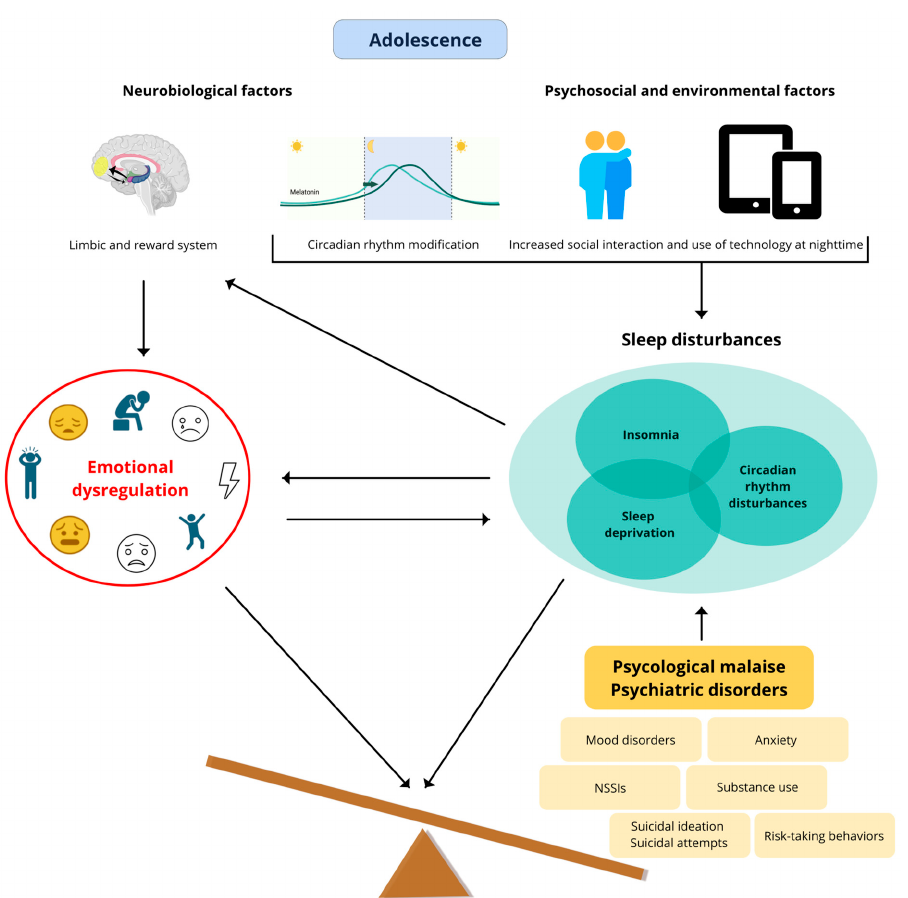
Figure 1. Neurobiological modifications in adolescents, circadian rhythm changes and mechanisms of development of psychiatric disorders. Legend. The adolescent brain faces many changes during a short period related to neurobiological modi fi cations combined with psychosocial and environmental factors. Deep brain areas such as the limbic and reward system areas (ventral striatum and amygdala) increase their neural activity (top on the left). This temporary hyperfunction of dopaminergic circuits can lead to emotional dysregulation (center on the left), augmenting the risk of developing psychological malaise and psychiatric disorders (bo tt om on the right) [12]. Moreover, circadian rhythm modi fi cations with delayed melatonin secretion (top center) occur during adolescence. These changes, together with environmental and psychosocial factors (increased social interaction and use of technology at nigh tt ime) (top on the right), may result in sleep disturbances (sleep deprivation, circadian rhythm disorders, insomnia) (middle on the right) [13,14]. Of note, sleep loss may decrease functional connectivity between the top-down control regions of the prefrontal cortex and the amygdala [1]. Sleep disorders can drive/worsen emotional dysregulation, which in turn may contribute to the onset and/or maintenance of sleep disturbances. Moreover, sleep disorders may increase the risk of psychological problems and psychiatric disorders, which in turn may induce and/or maintain sleep disturbances [15–17]. This review focuses on adolescents’ brain physiology and its implications for sleep changes, which may easily unlock potentially harmful conditions that can undermine or